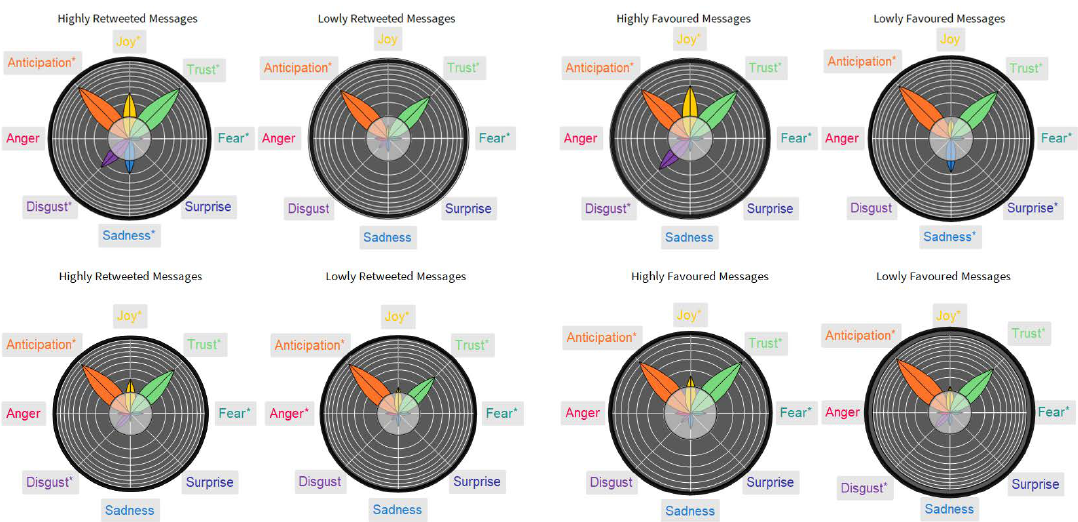
Figure 2. Multi-language analysis of the emotional profiles of highly/less retweeted ( left ) or liked ( right ) tweets in English ( top ) and in Italian ( low ). Petals indicate z -scores and are higher than 1.96 when falling outside of the semi-transparent circle. Asterisks highlight emotions z >